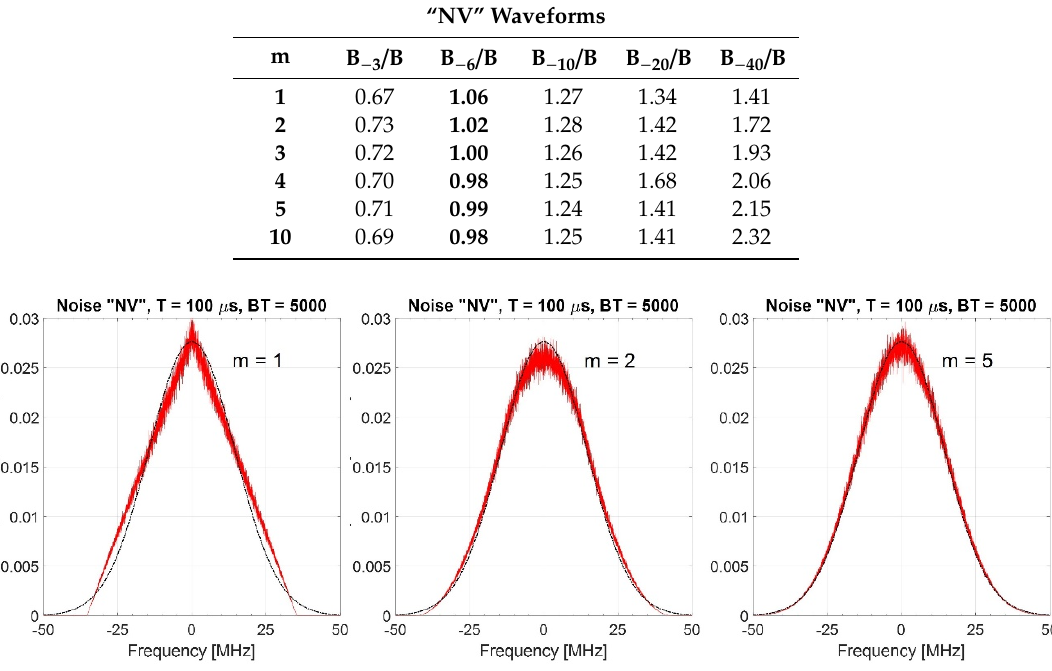
Figure 6. Spectrum of the “Normalized Variance”, i.e. “NV”, noise waveform (estimated on 1000 trials), BT = 5000. Dashed-line shows the Gaussian spectrum, m = 1, 2, 5.